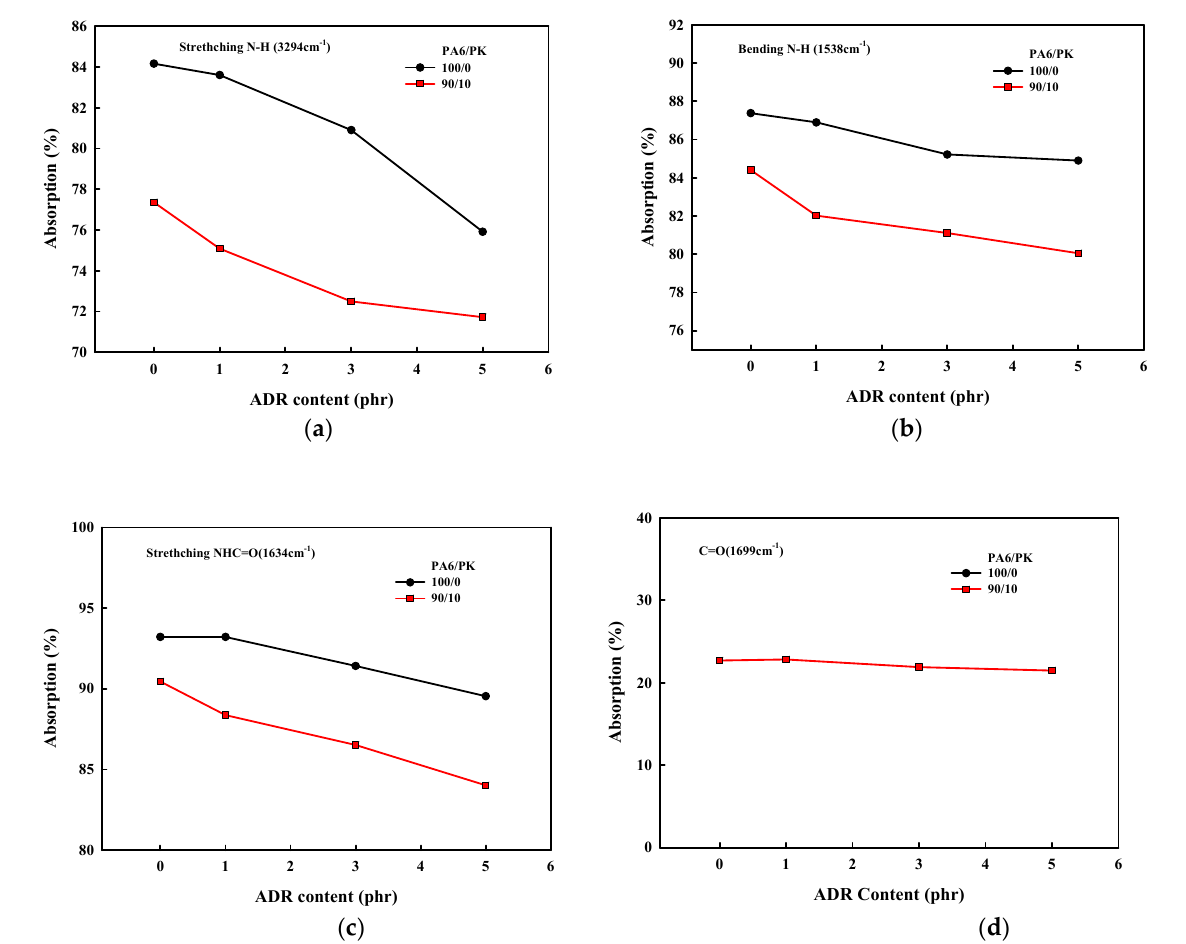
Figure 5. Effect of ADR content on the maximum absorption of the peaks due to amino and carbonyl groups in PA6 and PA6/PK blends:( a ) N–H stretching (3294 cm − 1 ); ( b ) N–H bending (1538 cm − 1 ); ( c ) NHC=O stretching (1634 cm − 1 ); ( d ) C=O (1699cm − 1 ).